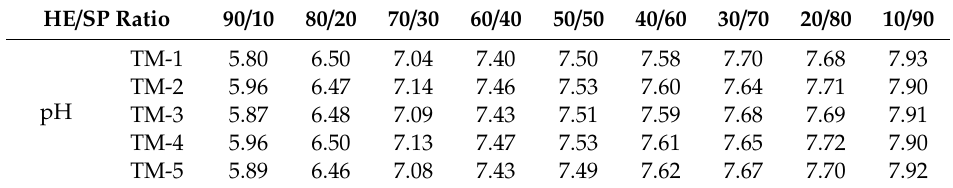
Table 5. Mass ratio of the Histosol KCl-extract (HE) to the saponite pulp (SP) and pH of the created series of Technosol mixtures (TM).